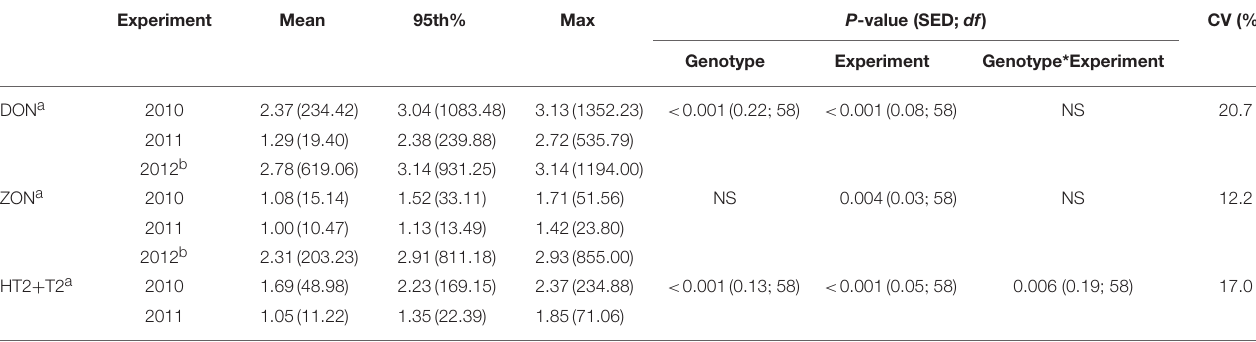
TABLE 5 | Deoxynivalanol (DON), HT2 + T2, and zearalenone (ZON) concentrations ( µ g kg − 1 ) described by the mean, 95th percentile, and maximum values in harvested grain of wheat genotypes in field experiments in 2010, 2011, and